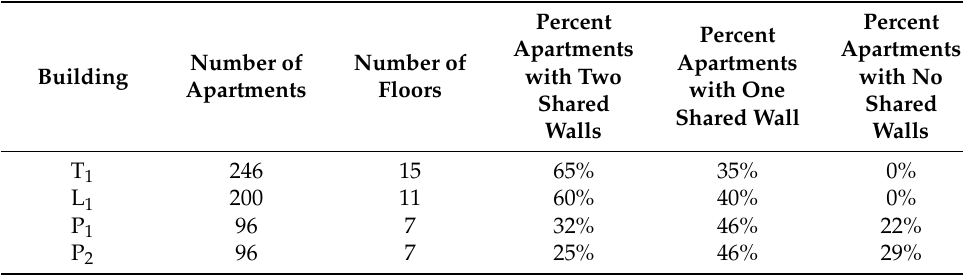
Table 1. Percent of apartments in each building that had two shared walls, one shared wall, or no shared walls with other apartments in the